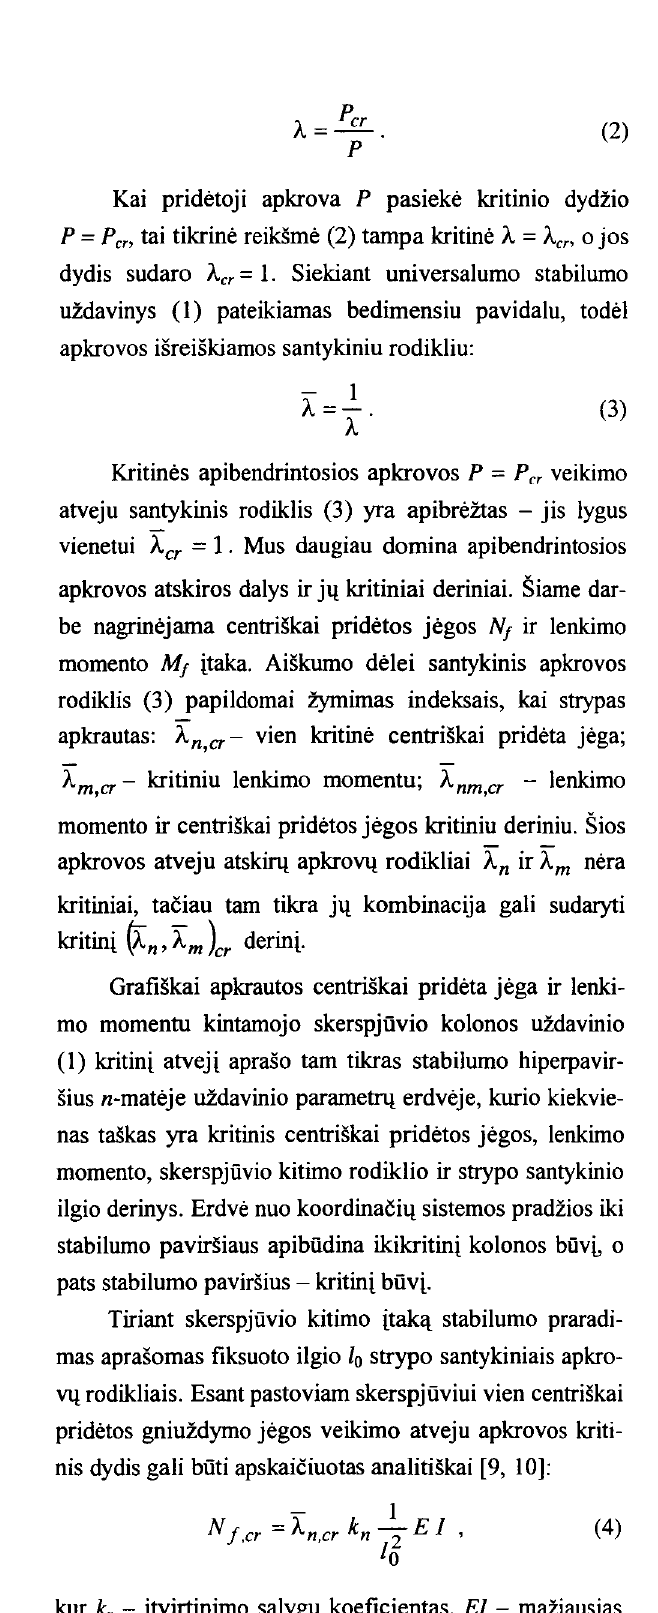
aprasoma dydziais: I - kolonos aukstis, a - dvitejo skerspjiivio sieneles plotis apatiniame gale, b - sieneles plotis virsutiniame gale, s - sieneles storis, f - dvitejo skerspjiivio juosttt pi otis, t- juosttt